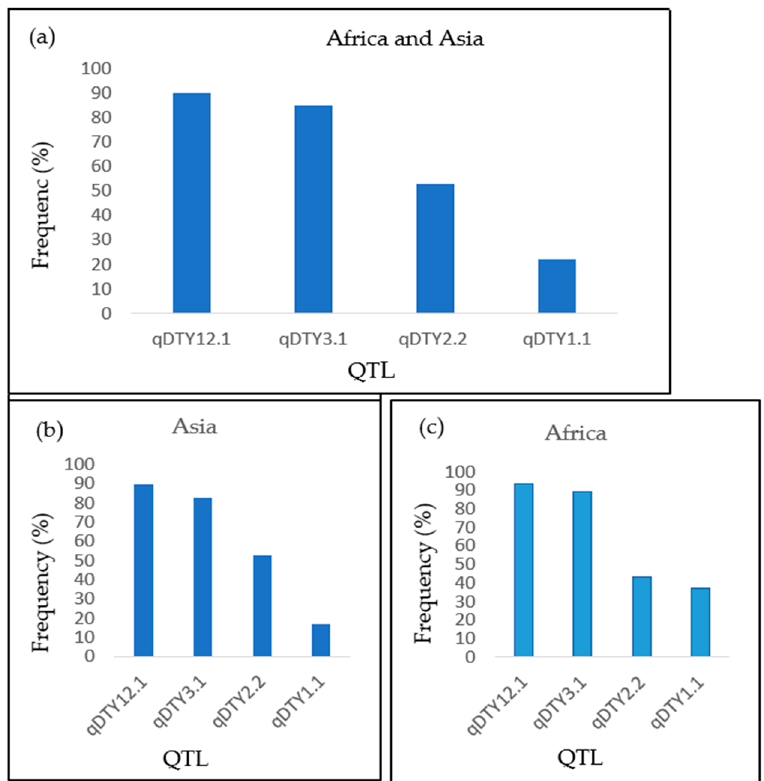
Figure 1. Frequency distribution of targeted QTLs in the evaluated genotypes; ( a ) the percentage of each QTL in the genotypes from both Africa and Asia; ( b ) the occurrence of each QTL in genotypes from Asia alone; ( c ) the frequency of each QTL in genotypes from Africa alone. All the evaluated genotypes formed a total of eight clusters, where the genotypes from Africa and these from Asia shared six clusters and the other two clusters were owned by the genotypes from Asia. The graphical view of the diversity of these genotypes is globally presented in the neighbor-joining tree (Figure 2) and detailed in the dendrogram (Figure A2 of the Appendix A).